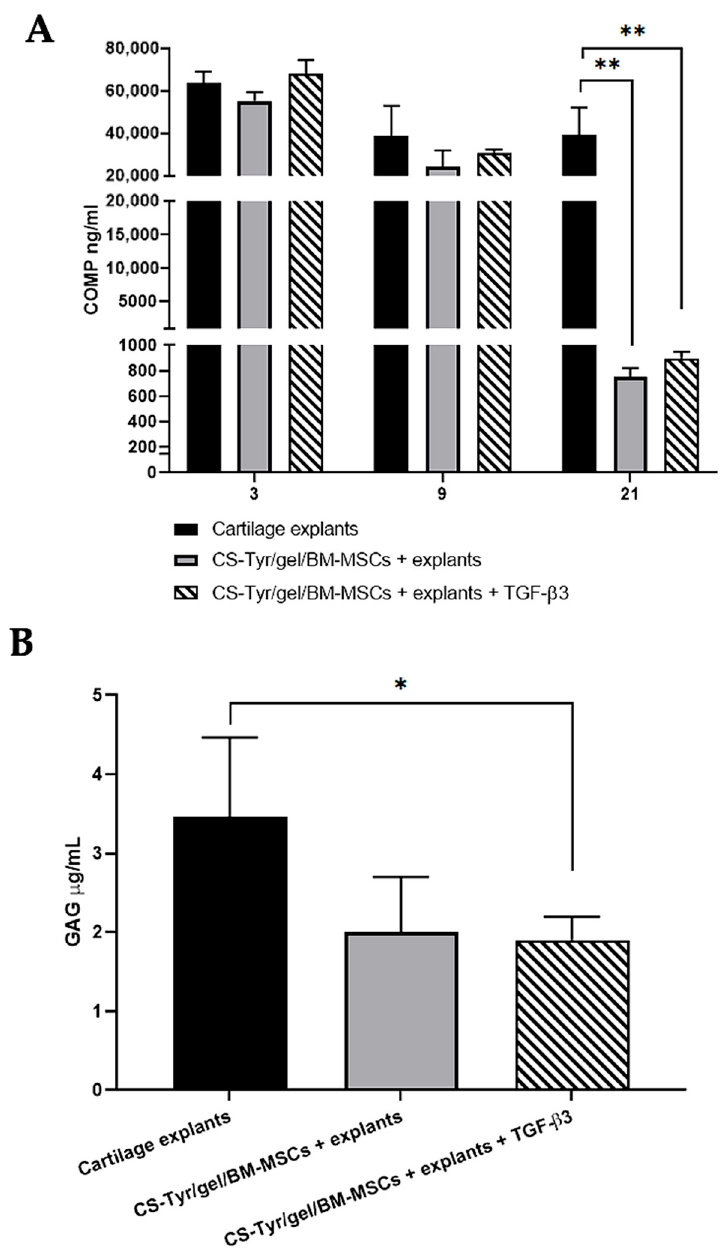
Figure 7. The release of ECM components from the human OA cartilage explants with and without the CS-Tyr/Gel/BM-MSCs during the 21 days of incubation chondrogenic medium. ( A ) The release of the cartilage oligomeric matrix protein (COMP) from the cartilage explants without and with the CS-Tyr/Gel/BM-MSCs hydrogel; incubated in chondrogenic medium with and without TGF- β 3 for 3, 9 and 21 days. ( B ). The release of glycosaminoglycans (GAGs) from the human OA cartilage explants with or without the CS-Tyr/Gel/BM-MSC composite, incubated in chondrogenic medium with or without TGF- β 3 for 21 days. Data are presented as mean ± SD and are significant at * p ≤ 0.05 and ** p ≤ 0.01 from no less than three repeats of three cell cultures.